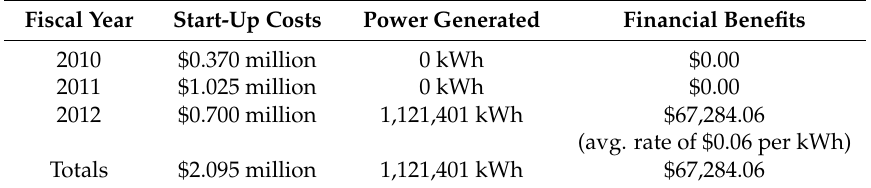
Table 1. Financial Costs and Benefits of Dewitt Pipeline Project to Logan City